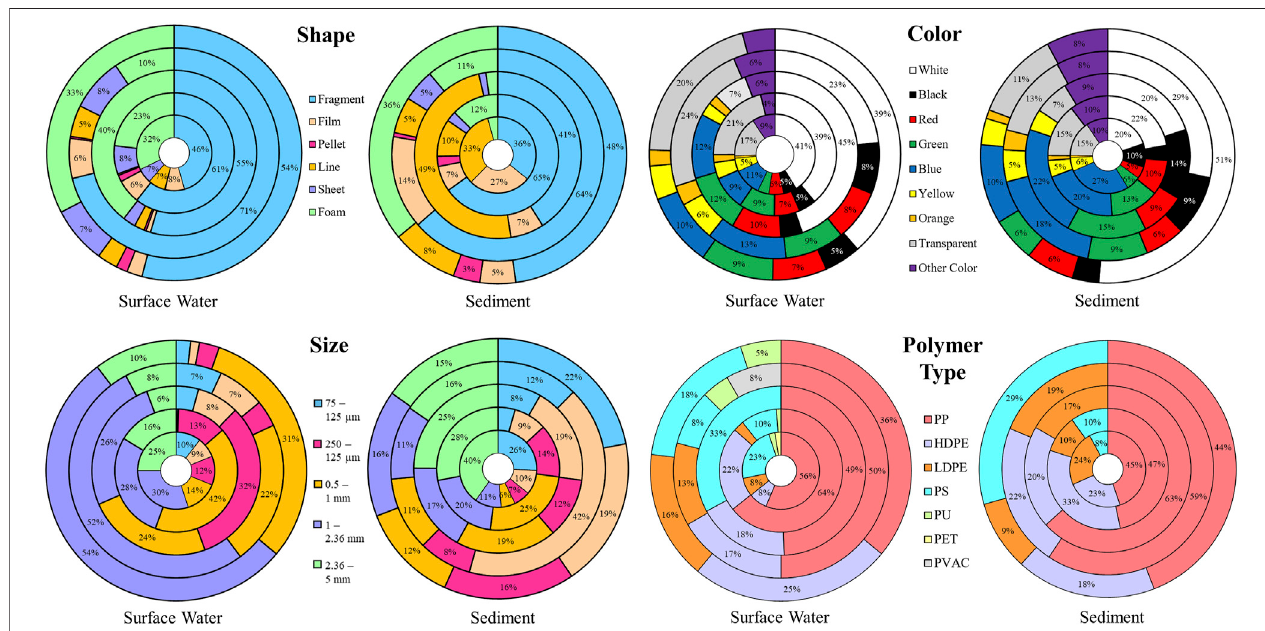
FIGURE 3| Distribution of characteristics ofmicroplastics insurface waters and sediments of fi ve river mouths in Manila Bay (from innermost to outermost circle) – Cañas, Meycauayan, Parañaque, Pasig, and Tullahan.